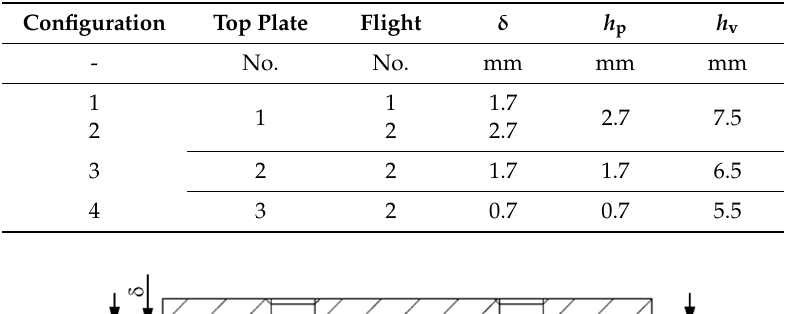
Table 6. Set of test configurations. Table 5. Positions and technical properties of pressure transducers. FSO: full scale output.